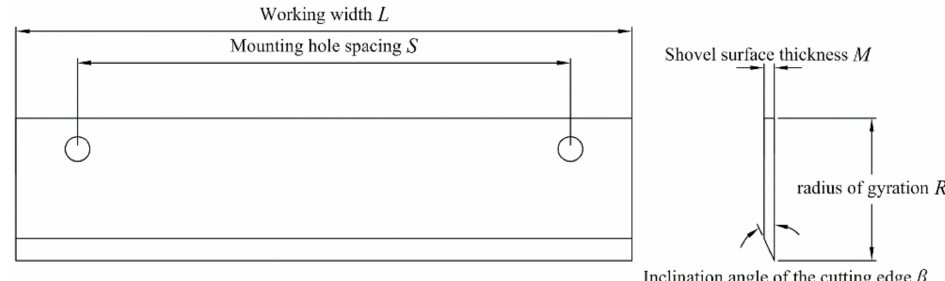
Figure 4. Structure of the counter-rotating